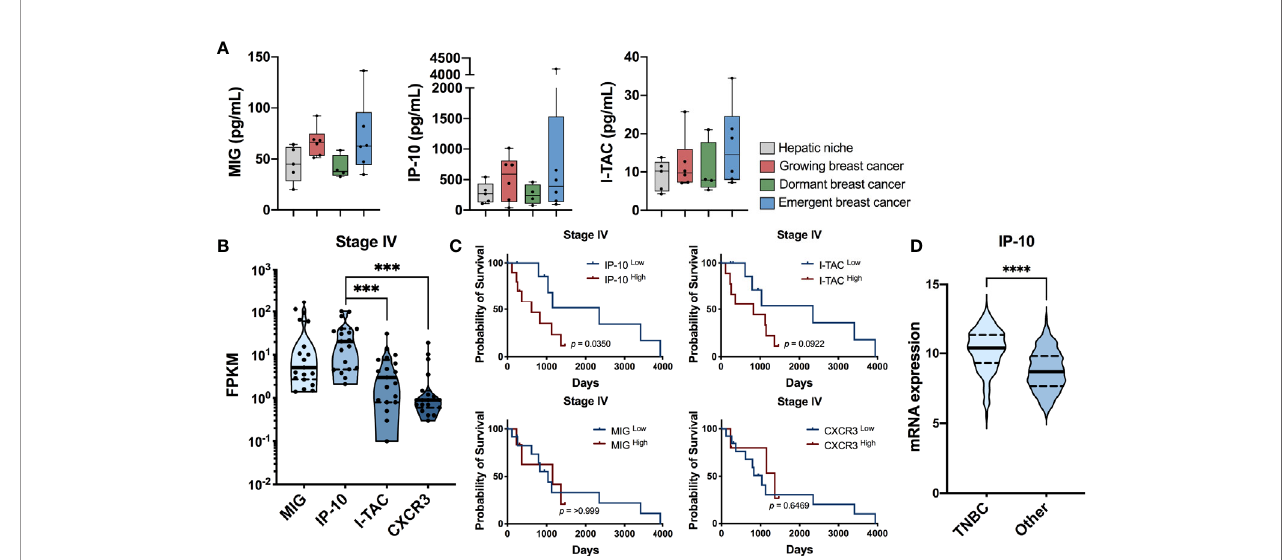
FIGURE 1 | IP-10 is associated with metastatic progression . (A) Secreted protein levels of MIG, IP-10 and I-TAC in an ex vivo liver MPS for the hepatic niche alone, with growing breast cancer cells, with dormancy breast cancer cells or with emergent breast cancer cells determined using Luminex technology (median with quartiles and range; Mann-Whitney test; n = 4-6 donors). Ex vivo data sourced from: Clark et al. (19). (B) RNA expression levels human patients with in stage IV metastatic breast cancer (log10 transformation, median with quartiles and range, Wilcoxon matched-pairs signed rank test, *** p < 0.001). (C) Survival of the aforementioned patients based on high and low expression of IP-10, I-TAC, MIG and CXCR3 (Kaplan-Meyer survival analyzed with Gehan-Breslow-Wilcoxon test). (B,C) Human TCGA breast cancer data sourced from: Human Protein Atlas version 19.3 (http://www.proteinatlas.org; n = 19 patients). (D) mRNA expression levels of IP-10 in patients with TNBC compared to all other subtypes of breast cancer (median with quartiles and range; Mann-Whitney test, **** p < 0.0001). The human breast cancer dataset (31, 32) containing the hormone status data was sourced from cBioPortal v3.6.11 (33, 34) (n = 1903